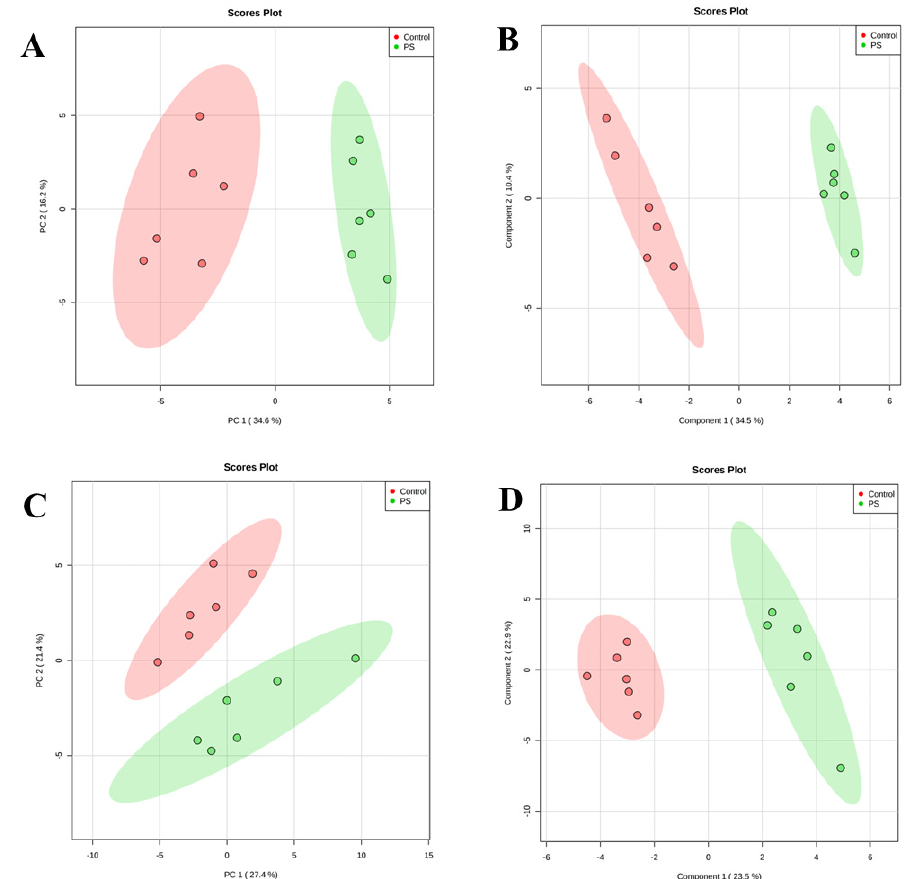
Figure 4. Principal component analysis (PCA) (left panels) and partial least square discriminant analysis (PLS-DA) (right panels) in a two-dimensional score plot of the relative abundance of ceramide species determined by RPLC-QTOF-MS in keratinocytes ( A,B ) and fibroblasts ( C,D ) of healthy subjects and patients with psoriasis vulgaris (Ps).